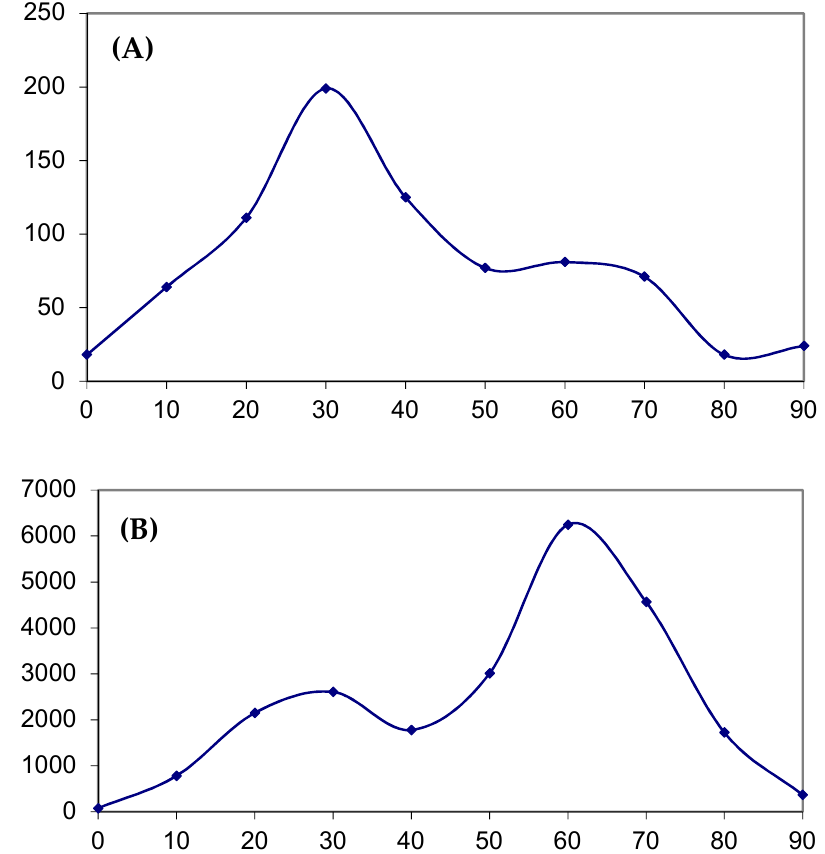
Figure 5. The weight distribution obtained using ( A ) the APOBEC3G weight matrix for skin adenocarcinoma (Table 2) and ( B ) the APOBEC1 weight matrix for bladder tissue (Supplementary Table S6). X axis: 0 stands for 0–9 interval of weights, 1 stands for the 10–19 interval, 2 stands for 20–29, etc.